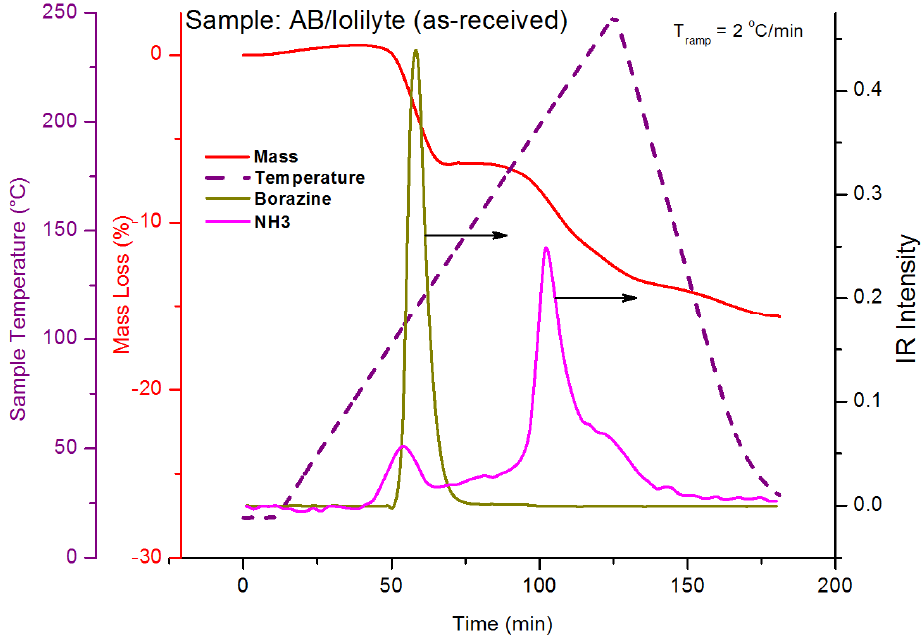
Figure 27. TG-IR curves for decomposition of ammonia borane–IoLiLyte composition. Reproduced from [28].